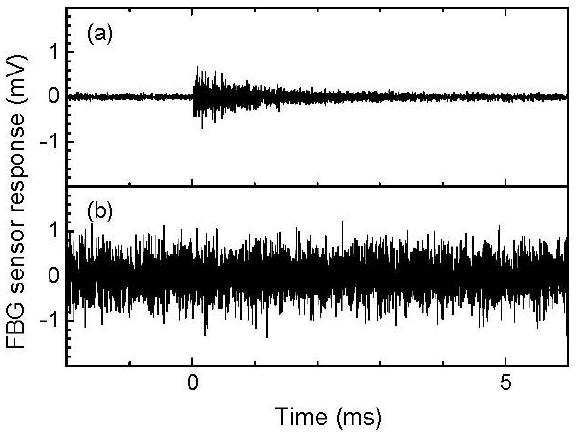
Figure 11. Responses to ultrasound that was propagated through an aluminum plate. These responses were detected via a broadband FBG sensor and acquired through a low-pass filter at a cut-off frequency of 500 kHz. ( a ) The 512-time-averaged response signal and ( b ) the non-averaged response